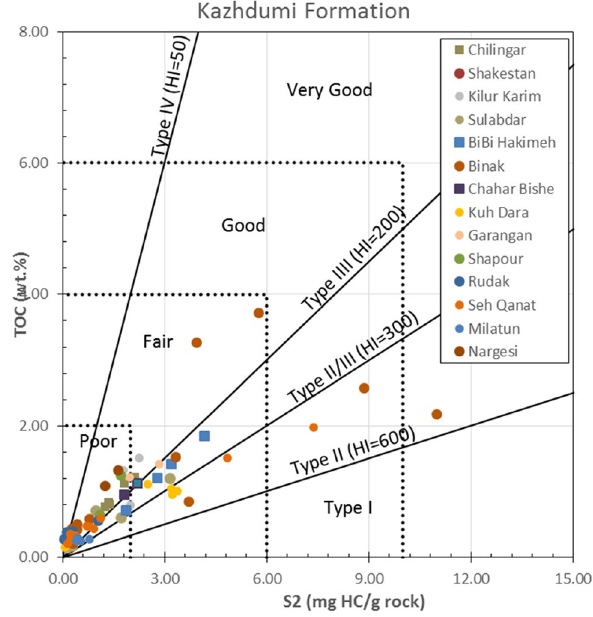
Fig. 9 S 2 versus TOC diagram of Kazhdumi selected samples from South Dezful Embayment (after Dahl et al.